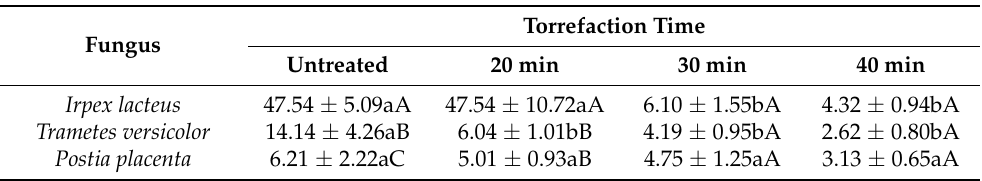
Table 3. Mass losses (%) of MDF residues, untreated and torrefied, when resisting attack of xy- lophagous